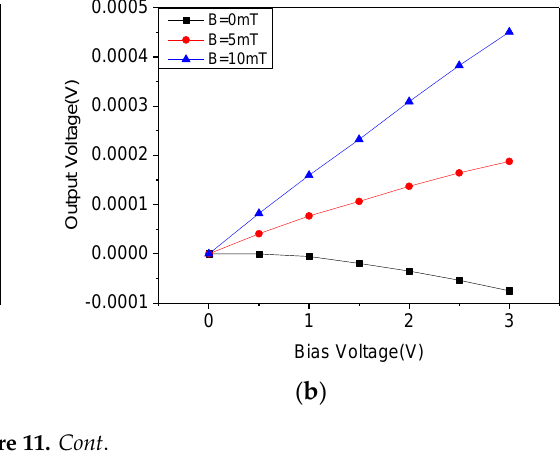
Figure 10. The orthogonal coupling structure.